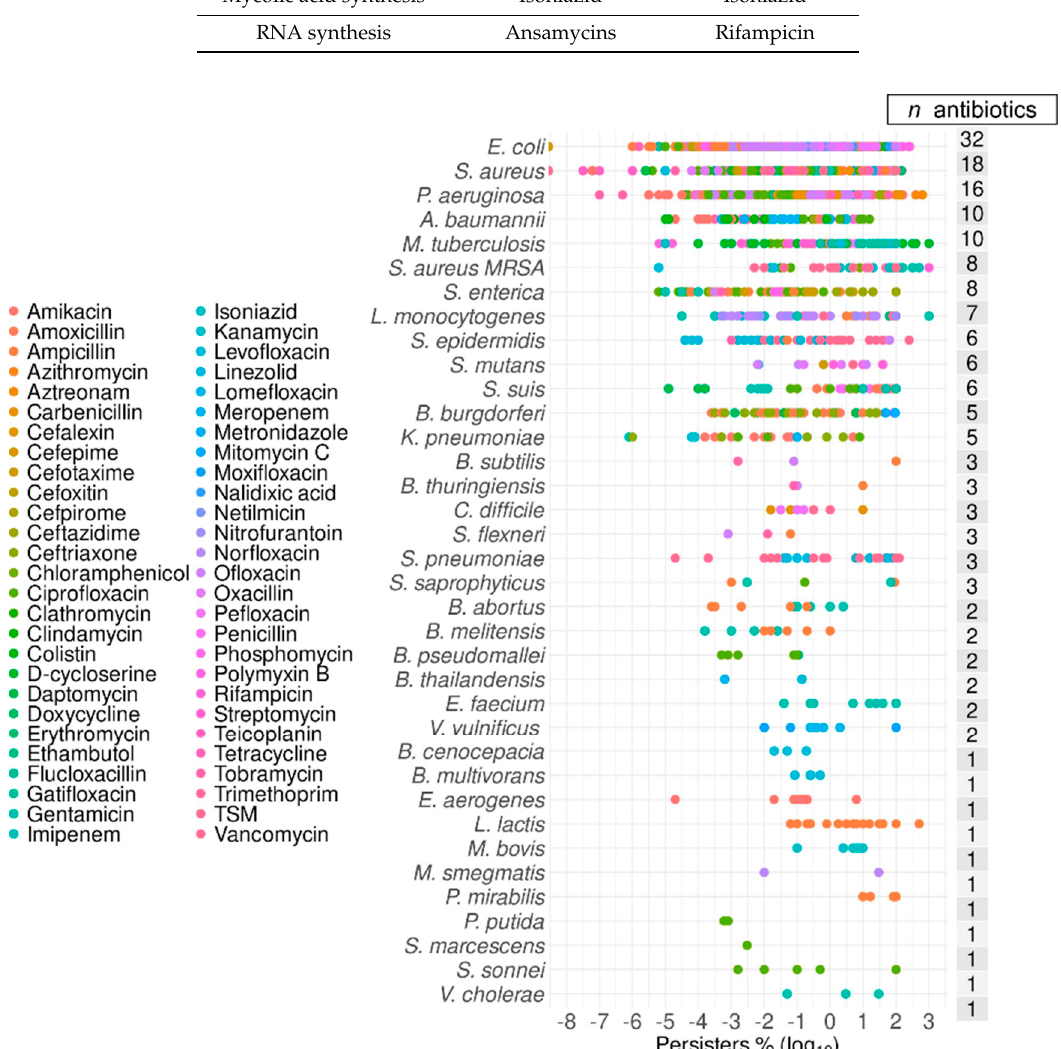
Figure 1. Antibiotics and bacterial species included in this survey. A total of 54 different antibiotics that were listed are represented by color-coded points along the list of 36 bacterial species. The bacteria were ordered according to the number of different antibiotics used in each species ( n antibiotics). Most antibiotics were highly represented in the top four species. TSM is the antifolate mixture of trimethoprim and sulphamethoxazole.